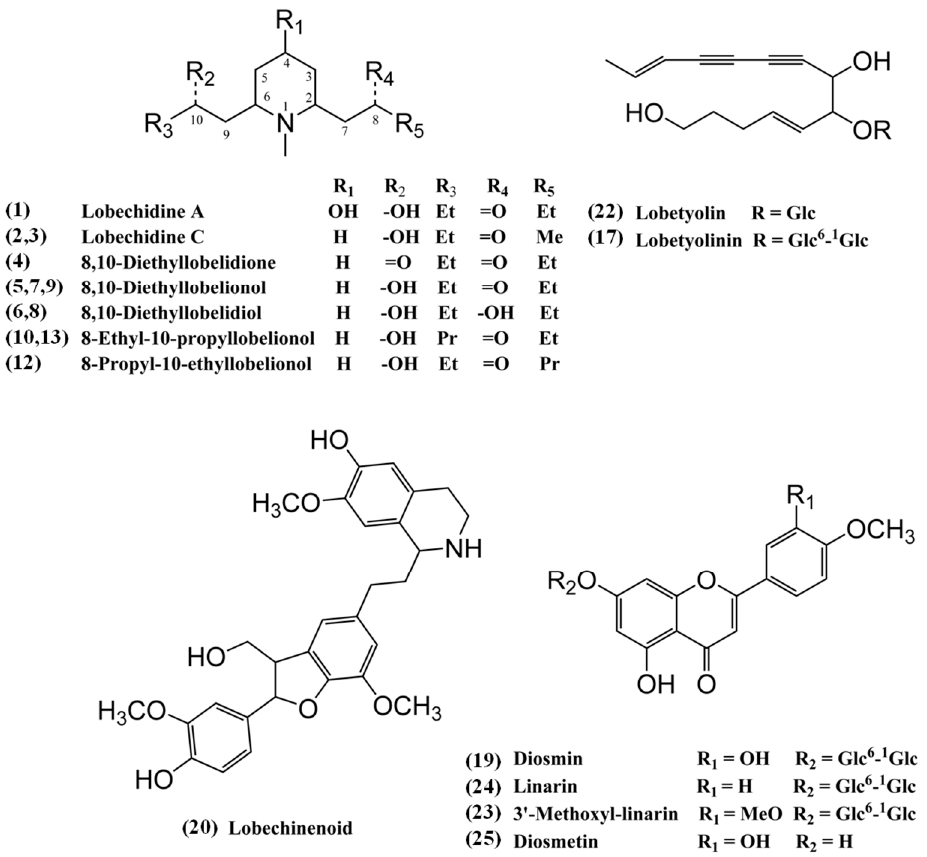
Figure 2. Chemical structures of the identified chemical constituents from L. chinensis .